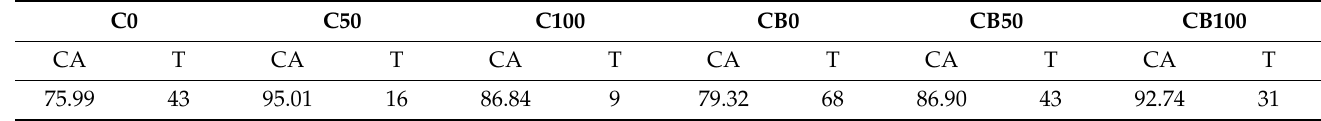
Table 4. The results of moisture management testing for standard (non-cationized) cotton fabric Table 7. DSA results for cationized cotton presented as mean value.